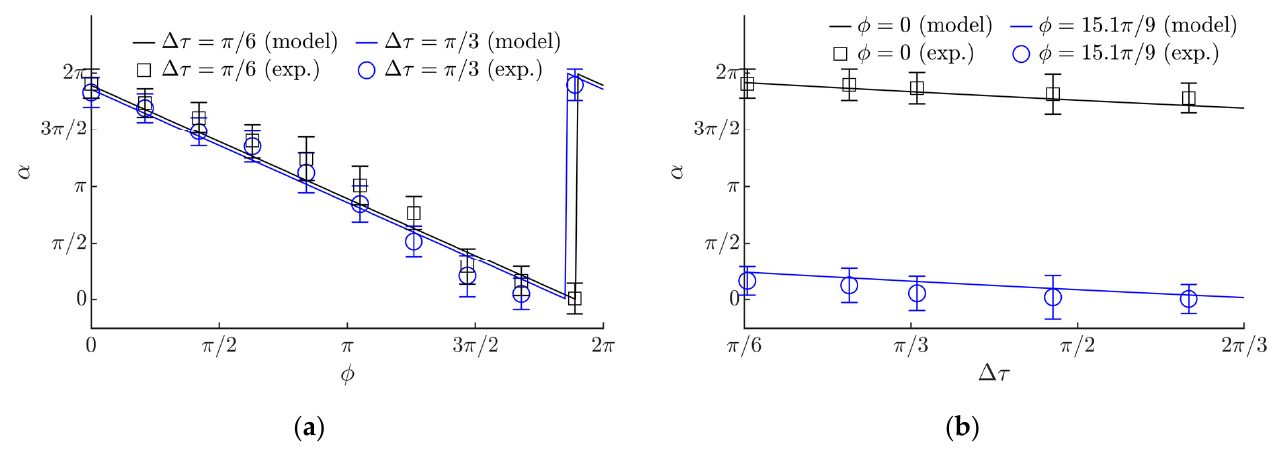
Figure 9. Experimental and modeling results of α depending on: ( a ) the phase shift ϕ when μ 1 = 0.1, μ 2 = μ 1 /8, g = 9.81 m/s 2 , A e = 0.28 mm, ω = 62.8 rad/s, ε = π /2; ( b ) Δ τ when μ 1 = 0.1, μ 2 = μ 1 /8, g = 9.81 m/s 2 , A e = 0.28 mm, ω = 62.8 rad/s, ε = π /2.